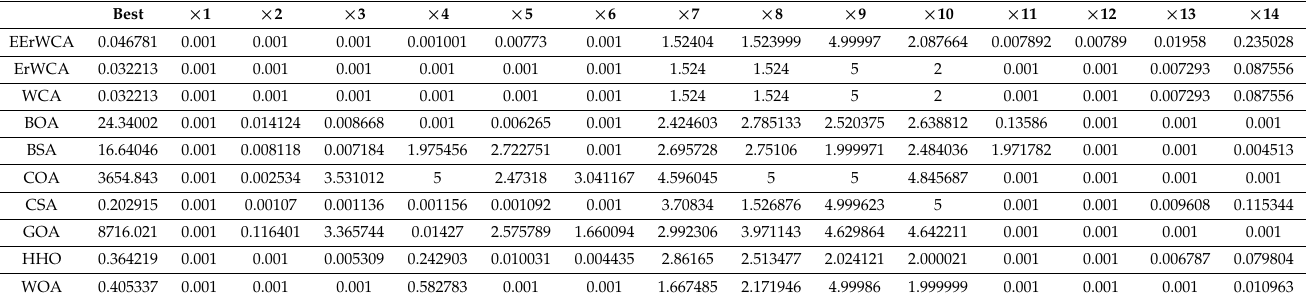
Table 6. Results of EErWCA versus other metaheuristics on optimal design of industrial refrigera- tion system.